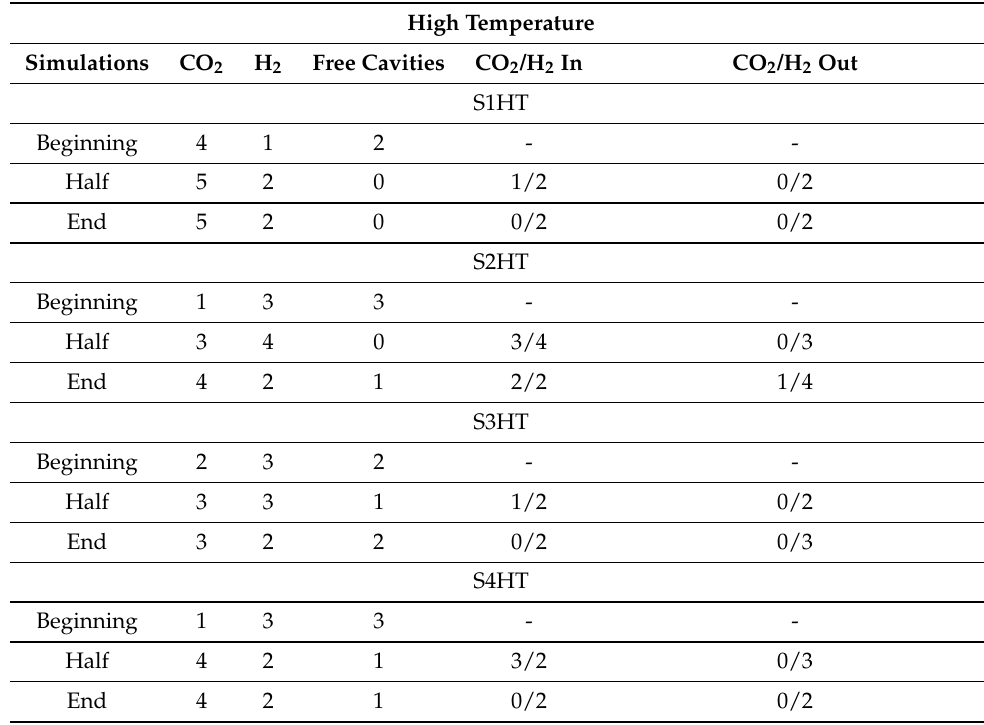
Table 3. Simulations for the HT runs (312 K and 1 bar).